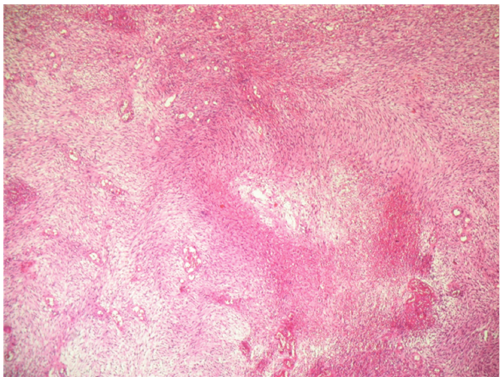
Figure 3: Irregular polypoid formation with white-grey to tan appearance. Note the presence of microcysts.